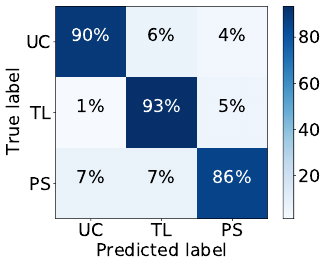
Figure 6. The confusion matrix for arm rule detection.